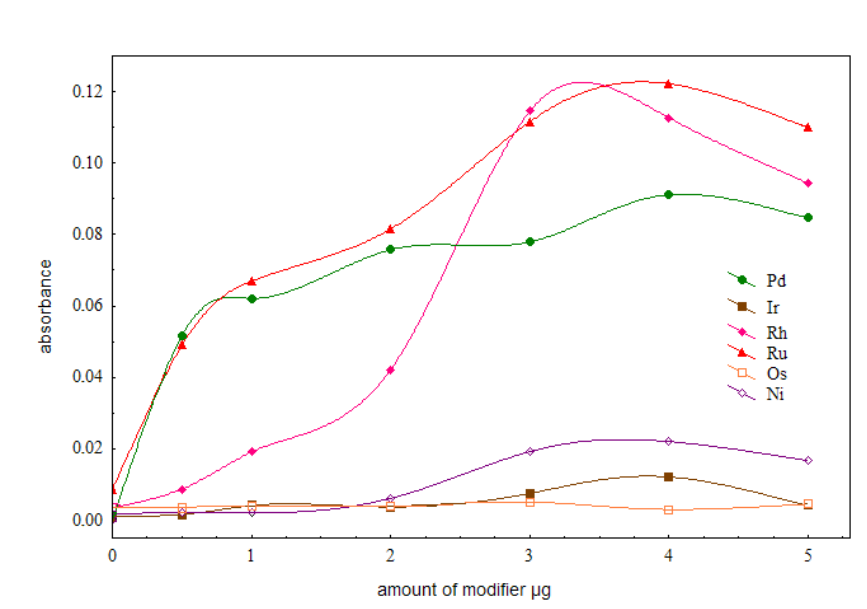
Fig. 2 The arsenic analytical system versus the amount of the modifier (1